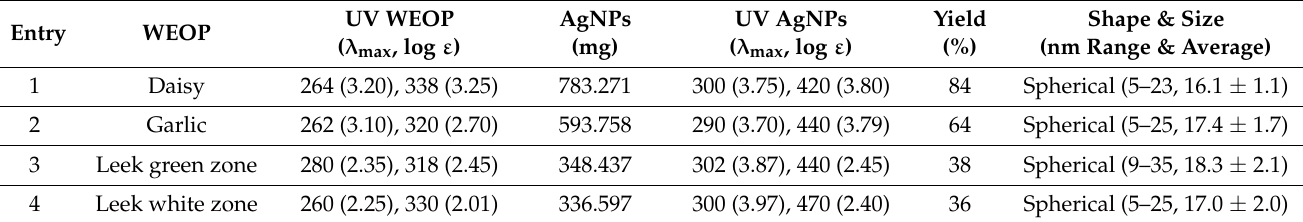
Table 1. UV-Vis data, quantities of AgNPs obtained and reaction yields.